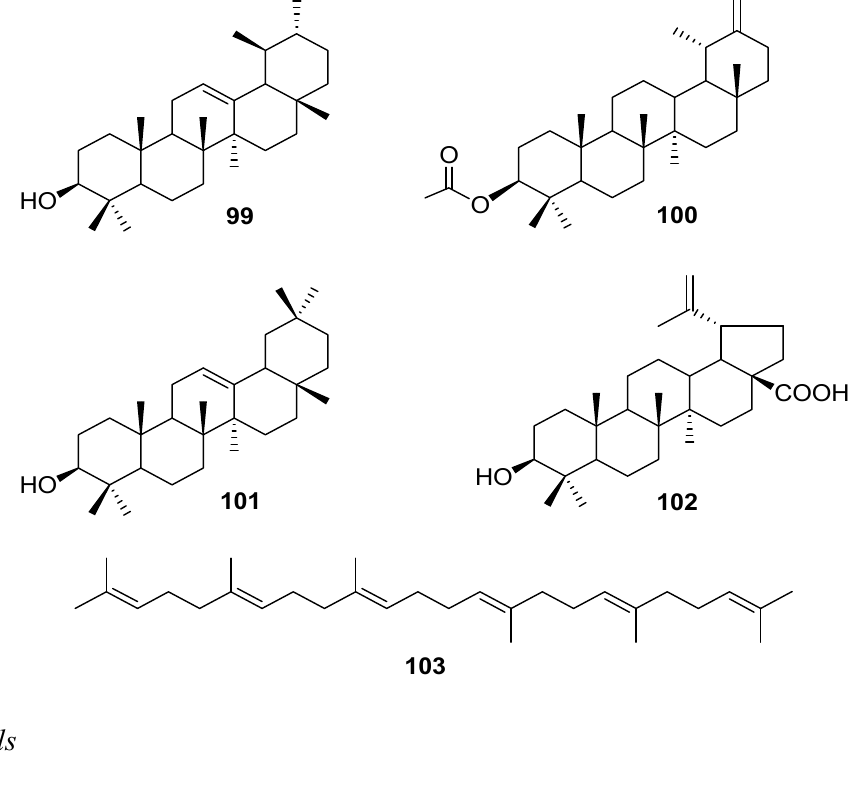
Figure 4. Chemical structures of triterpenes isolated from the genus Gnaphalium .